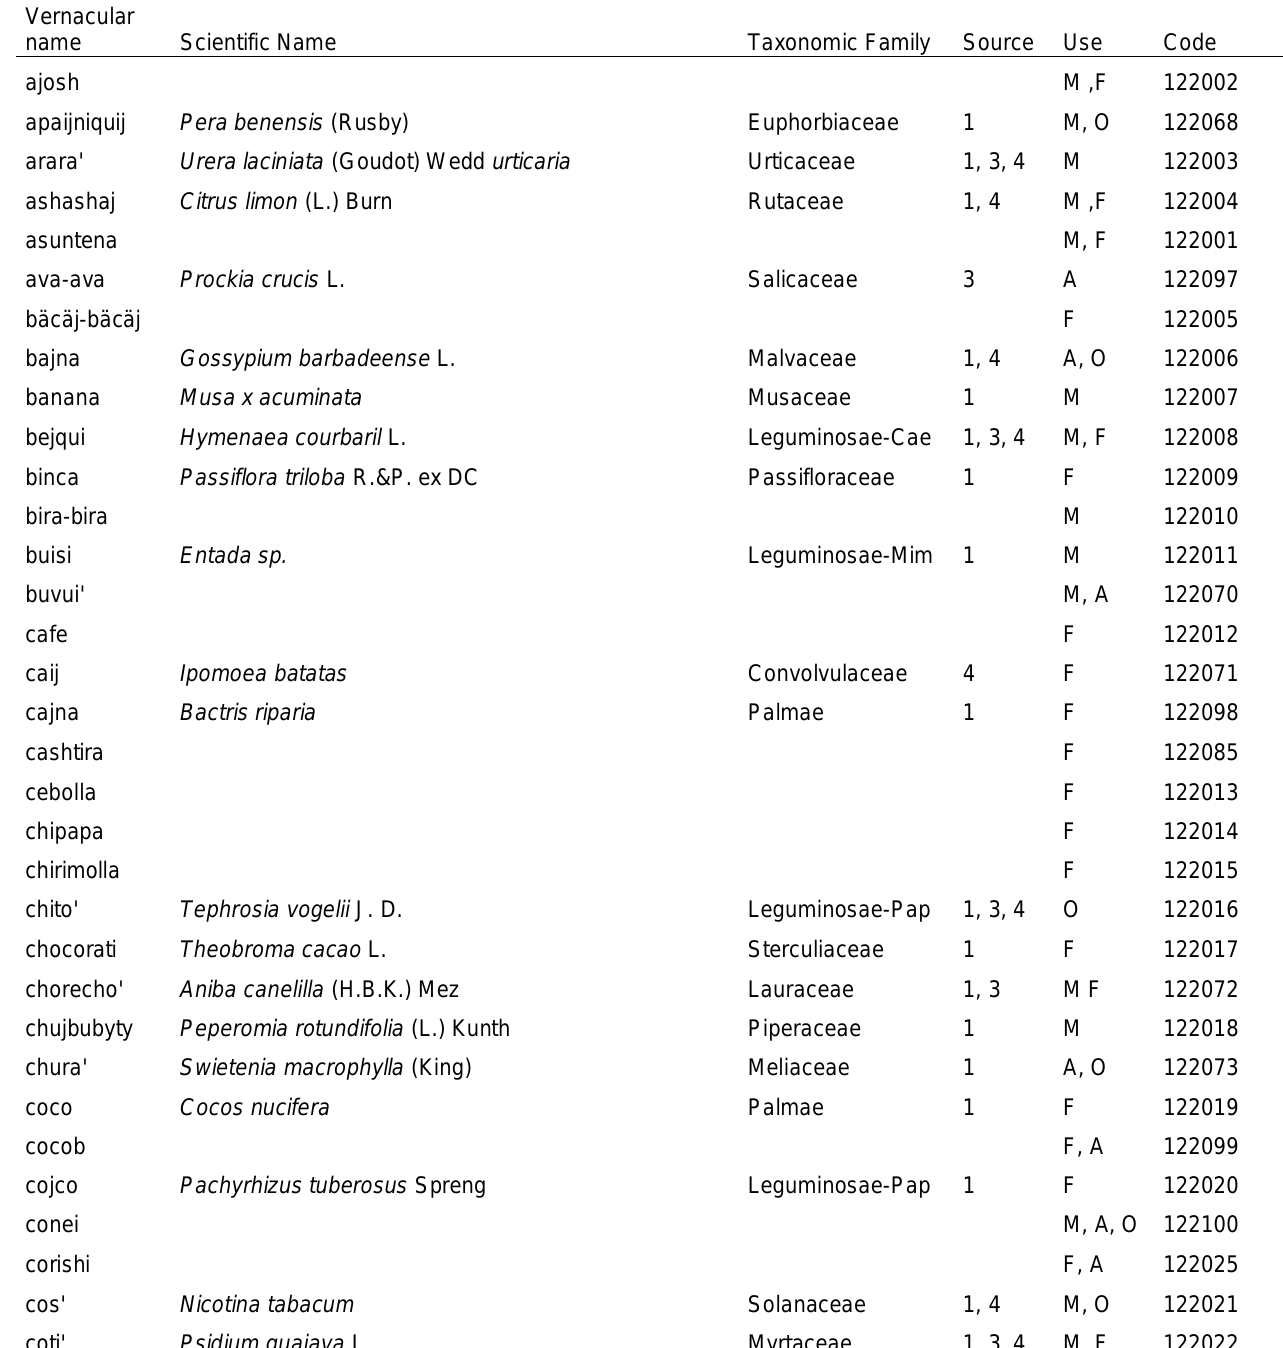
Table 1. List of species inventoried in homegardens in two Tsimane’ villages. Uses code as Medicinal:M, Food:F, Artisanal:A,